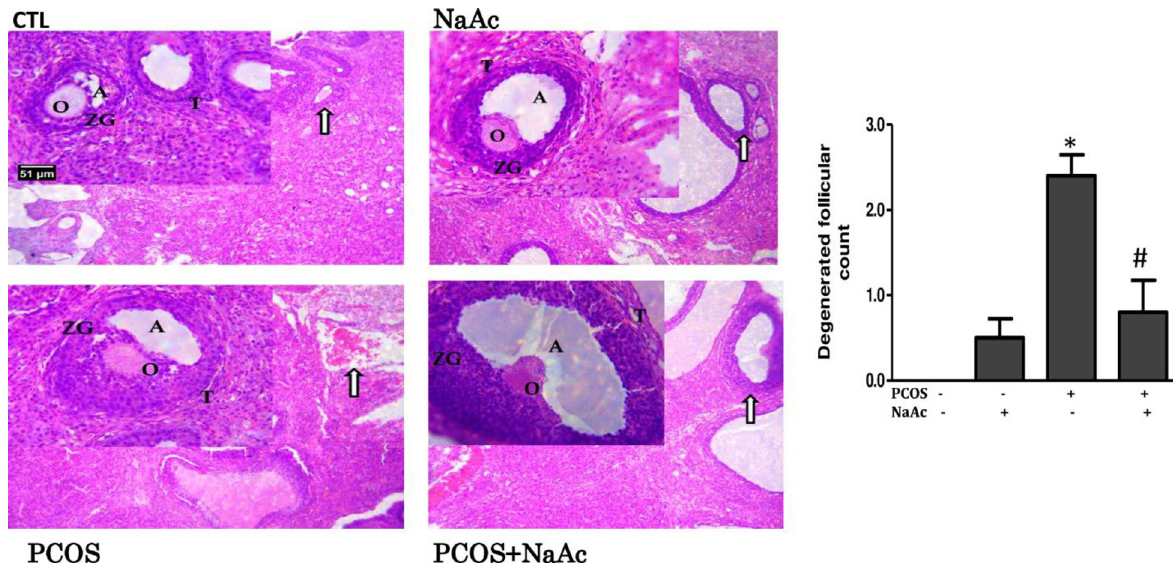
Fig 2. Impact of sodium acetate on the histomorphology of ovaries in LET-induced PCOS rat model. The photomicrographs of ovarian tissues show ovarian tissue with normal follicles and normal antrum, granulosa cells, thecal cells and oocyte in control animals (CTL), ovarian tissue with normal follicles and normal granulosa cells, thecal cells, oocyte and large antrum in NaAc-treated animals (NaAc), ovarian tissue with degenerated follicles and disrupted granulosa cells, thecal cells, antrum and oocyte in PCOS animals (PCOS) and ovarian tissue with preserved follicles and normal granulosa cells, thecal cells, oocyte and large antrum in PCOS+NaAc-treated animals; (H & E paraffin stain; transverse section; Scale bar 51 μ m). Oocyte (O); Antrum (A); Thecal cells (T); Granulosa cell (ZG). Data are expressed as mean ± SD. n = 6. Data were analyzed by one-way ANOVA followed by Bonferroni post hoc test . ( � p < 0.05 VS. CTL; # p < 0.05 VS. PCOS). Control (CTL); Polycystic ovarian syndrome (PCOS); Sodium acetate